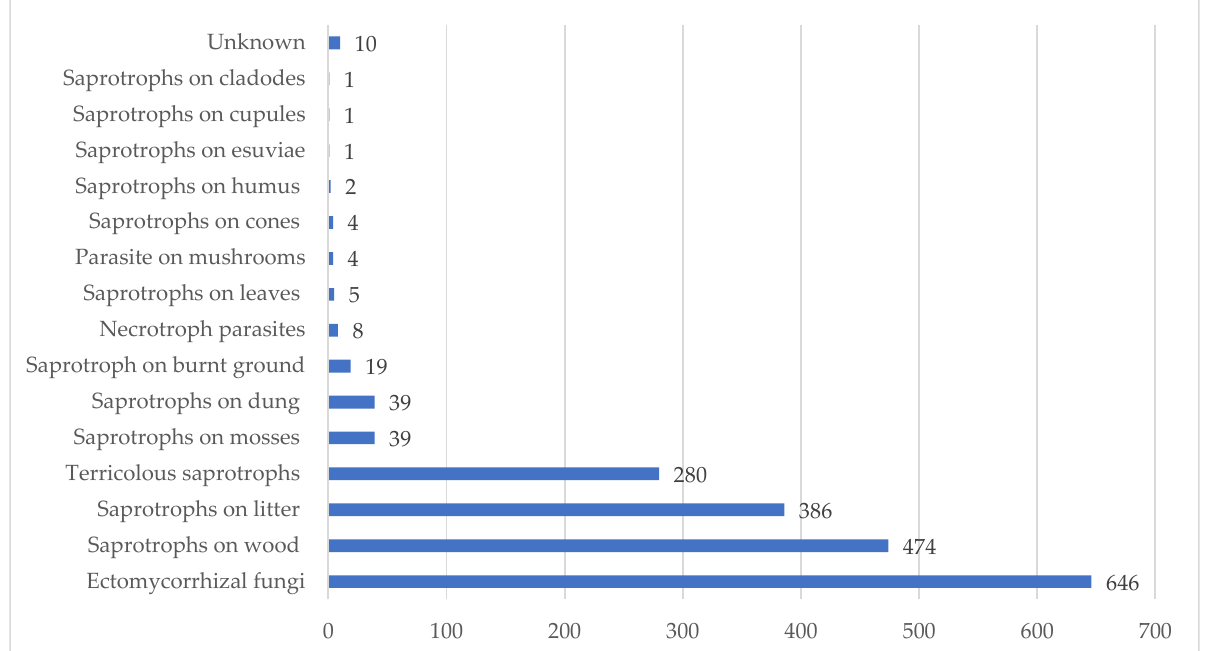
Figure 3. Number of taxa per ecological categories.